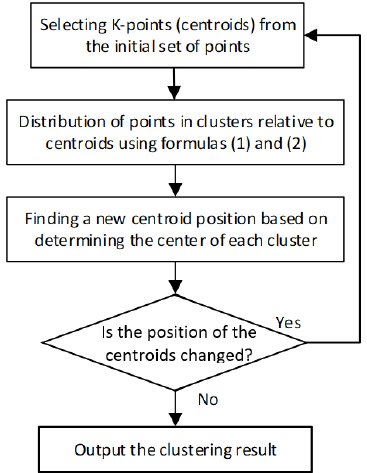
Figure 1. The basic steps of the improved k-means clustering algorithm.